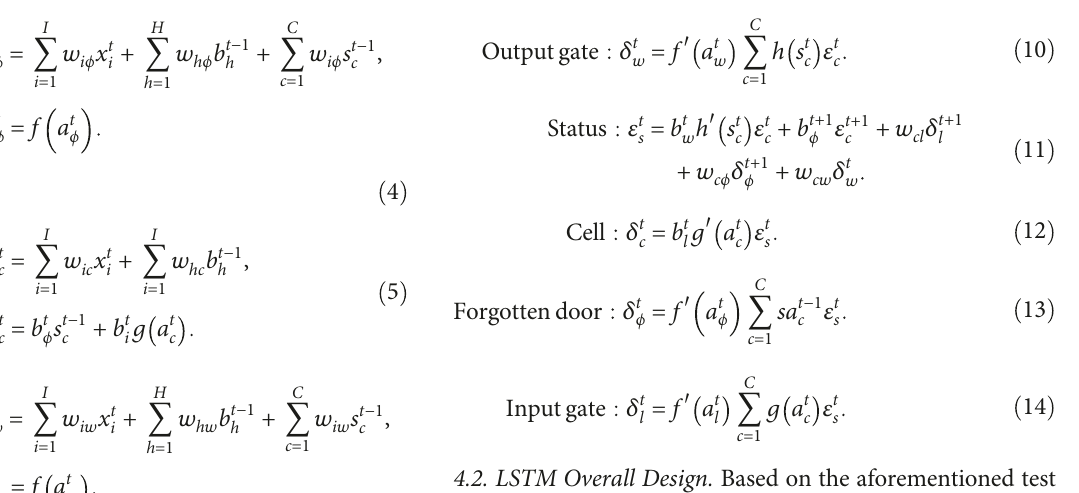
Figure 8: Internal structure of the memory